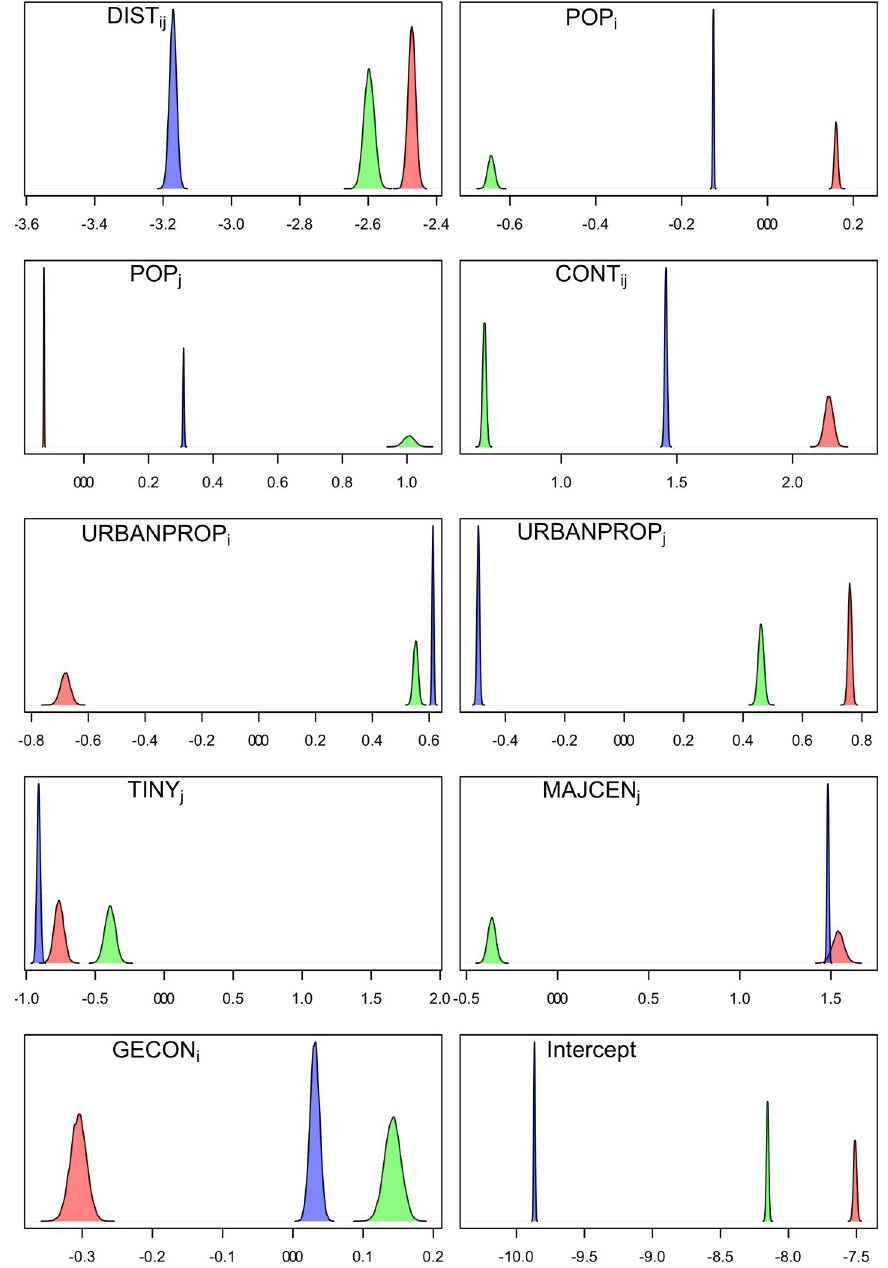
Fig 3. Posterior distribution of coefficients selected based on the best fine-scale model (red) compared to parameter values we would get when fitting using the broad-scale modeling approach while covariates are restricted to those selected in the best fine-scale model (red); and compared to parameter values we would get when fitting using the intermediate-scale modeling approach while covariates are restricted to those selected in the best fine-scale (blue). All coefficients were significant at least at the 0.05